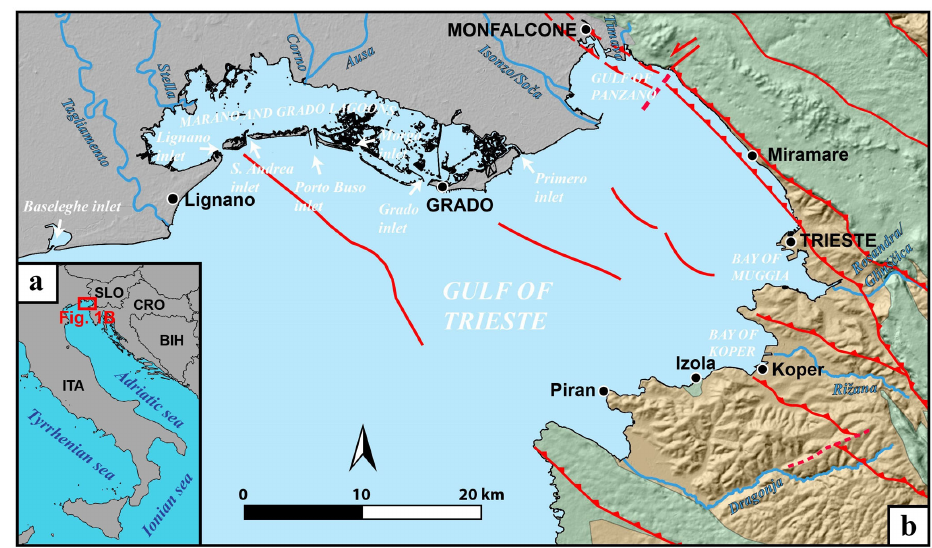
Figure 1. Location of the study area; (a) regional map; (b) a simplified geological map of the area (following Biolchi et al., 2016; Busetti et al., 2010a; Carulli et al., 2006; Carulli, 2011; EMODnet, 2018; Jurkovšek et al., 2016; Placer et al., 2010; Placer, 2015; Pleniˇcar et al., 1969). Mesozoic carbonates are marked with green, Eocene flysch with orange and Quaternary sediment with grey.